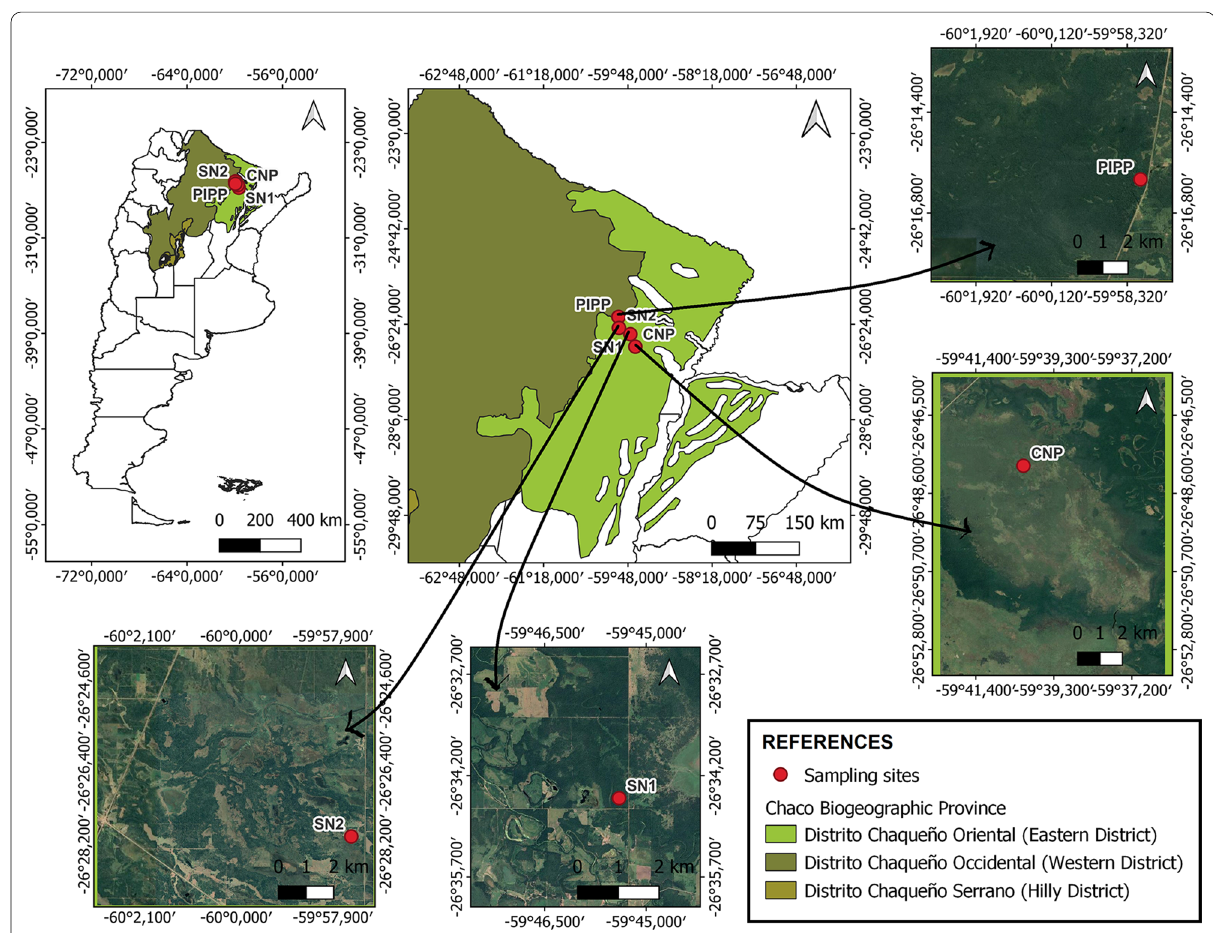
Fig. 1 Study area in Eastern Chaco District of Chaco Biogeographic Province, Argentina. PIPP Pampa del Indio Provincial Park, CNP Chaco National Park, SN1 semi-natural site 1, SN2 semi-natural site